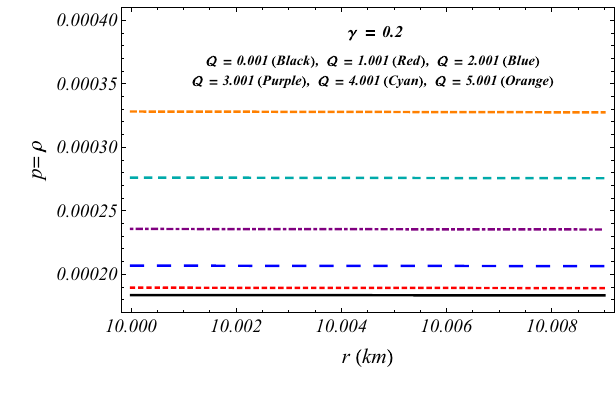
Fig. 3 Variation of pressure and density inside the thin